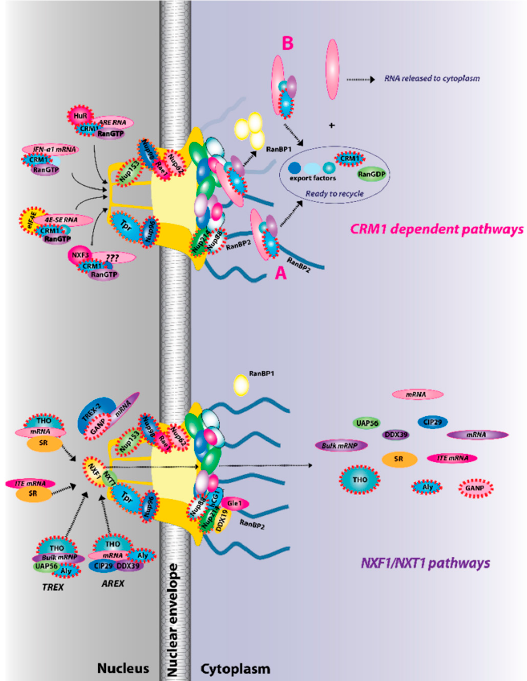
Figure 2. The two major RNA export receptor pathways, nuclear RNA export factor 1 (NXF1)/nuclear transport factor 2-like export 1 (NXT1) and chromosome maintenance protein 1 (CRM1), are shown, and both are dysregulated in cancer. There are multiple routes to engage either of these pathways. For example, for the NXF1/NXT1 pathways, there are complexes that rely on ALY/REF (transcription export (TREX) and AREX) and also on GANP (TREX2). There are the intronless H2a RNAs with intronless transport elements (ITEs) that rely on SR proteins but additionally some intron-containing RNAs also require SR proteins. For the NXF1/NXT1 pathway, cargo release depends on DDX9/Gle1. There are also multiple routes to engage the CRM1 pathways. These are depicted for IFN1 α , HuR, eIF4E, and NXF3. For the CRM1 pathway, cargo release involves RanGTP hydrolysis through either the RanBP1 or RanBP2 pathways ( A ). For the case of eIF4E overexpression ( B ), RanBP2 levels are reduced (depicted by fibrils in shadow) and RanBP1 levels are increased. Thus, the RanBP1 release pathways are thought to predominate. Once cargoes are released from both the NXF1/NXT1 and CRM1 pathways, exportins and associated factors are recycled (not shown). Only four cytoplasmic fibrils and four nuclear basket protrusions are displayed for simplicity of presentation (as there are eight fibrils per nuclear pore complex (NPC)). Factors known to be involved in cancer are encapsulated in red dashed lines. This is not an exhaustive list of all NPC factors that are dysregulated in cancer but highlights the fact that all facets of the NPC can be impacted (nuclear basket, central channel, and cytoplasmic